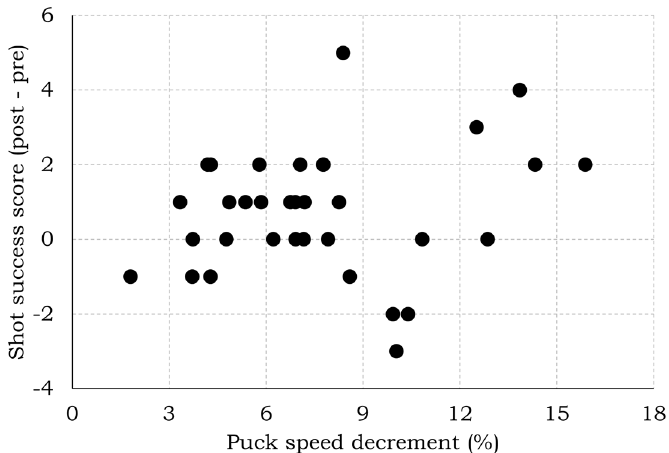
Figure 3. Relative puck speed decrement (sum of all SS and WS trials) over an overall shot success score (positive values represent a higher shot accuracy after the IHCT).